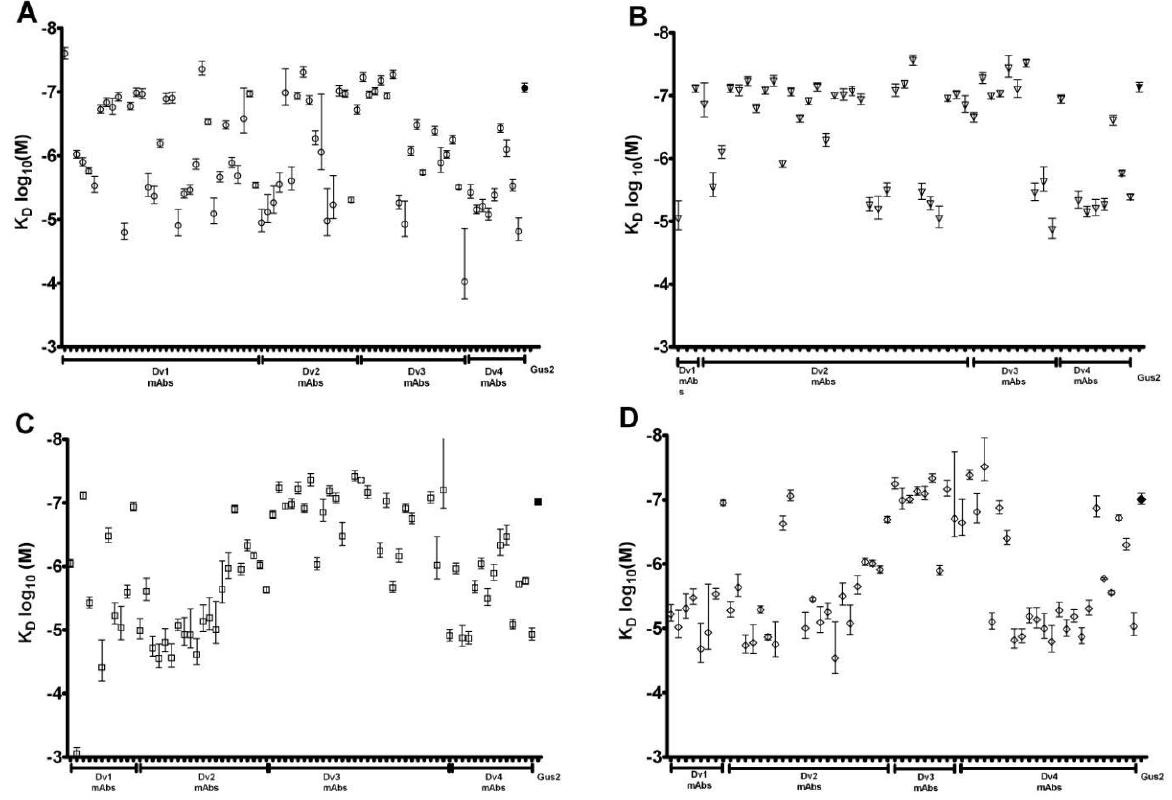
Figure 2. Affinities of DENV NS1 reactive mAbs detected by RWG. ( A ) DENV1 NS1 reactive mAbs, ( B ) DENV 2 NS1 reactive mAbs, ( C ) DENV3 NS1 reactive mAbs, and ( D ) DENV4 NS1 reactive mAbs. The affinity values (K ) of these NS1 mAbs ranged from D 10 −8 to 10 −3 M. Error bars represent mean ± standard error of the mean for n = 4. The data point with solid fill is that obtained from the capture antibody (Gus 2) employed in the currently marketed Alere Dengue early diagnostic test.